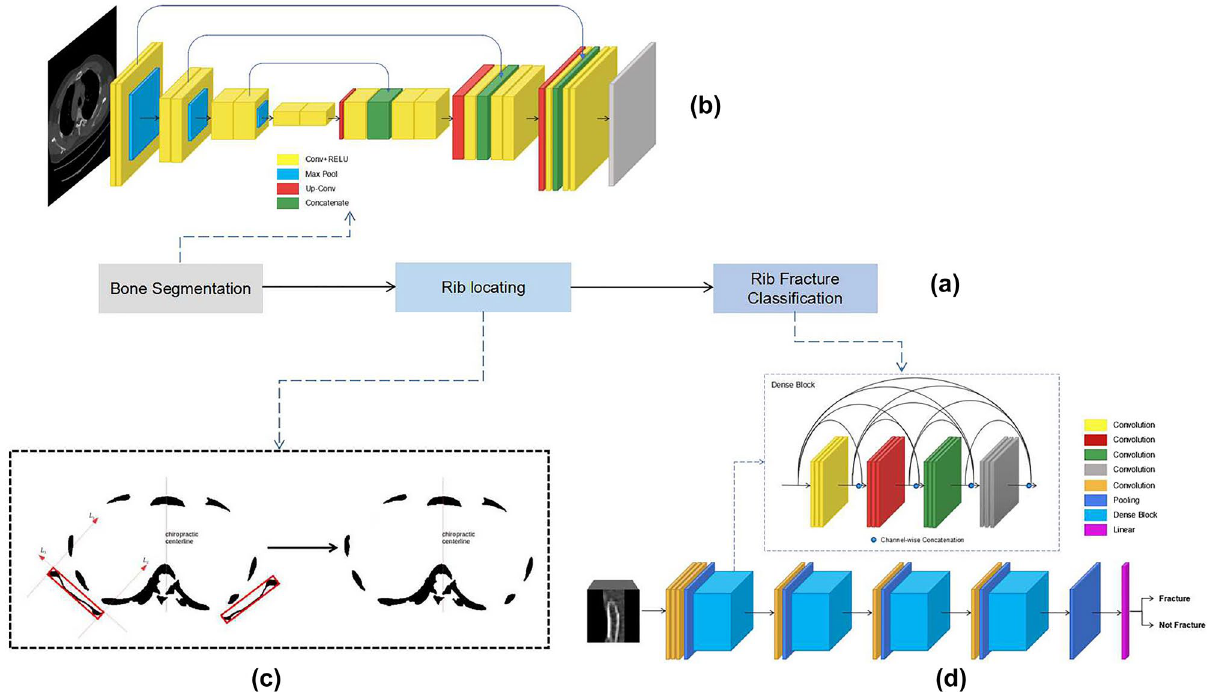
Figure 2. The pipeline for detecting rib fractures from CT scans. The fracture detection task was divided into three stages, including bone segmentation, rib location, and rib fracture classification ( a ). ( b ) bone segmentation; ( c ) rib location; ( d ) rib fracture